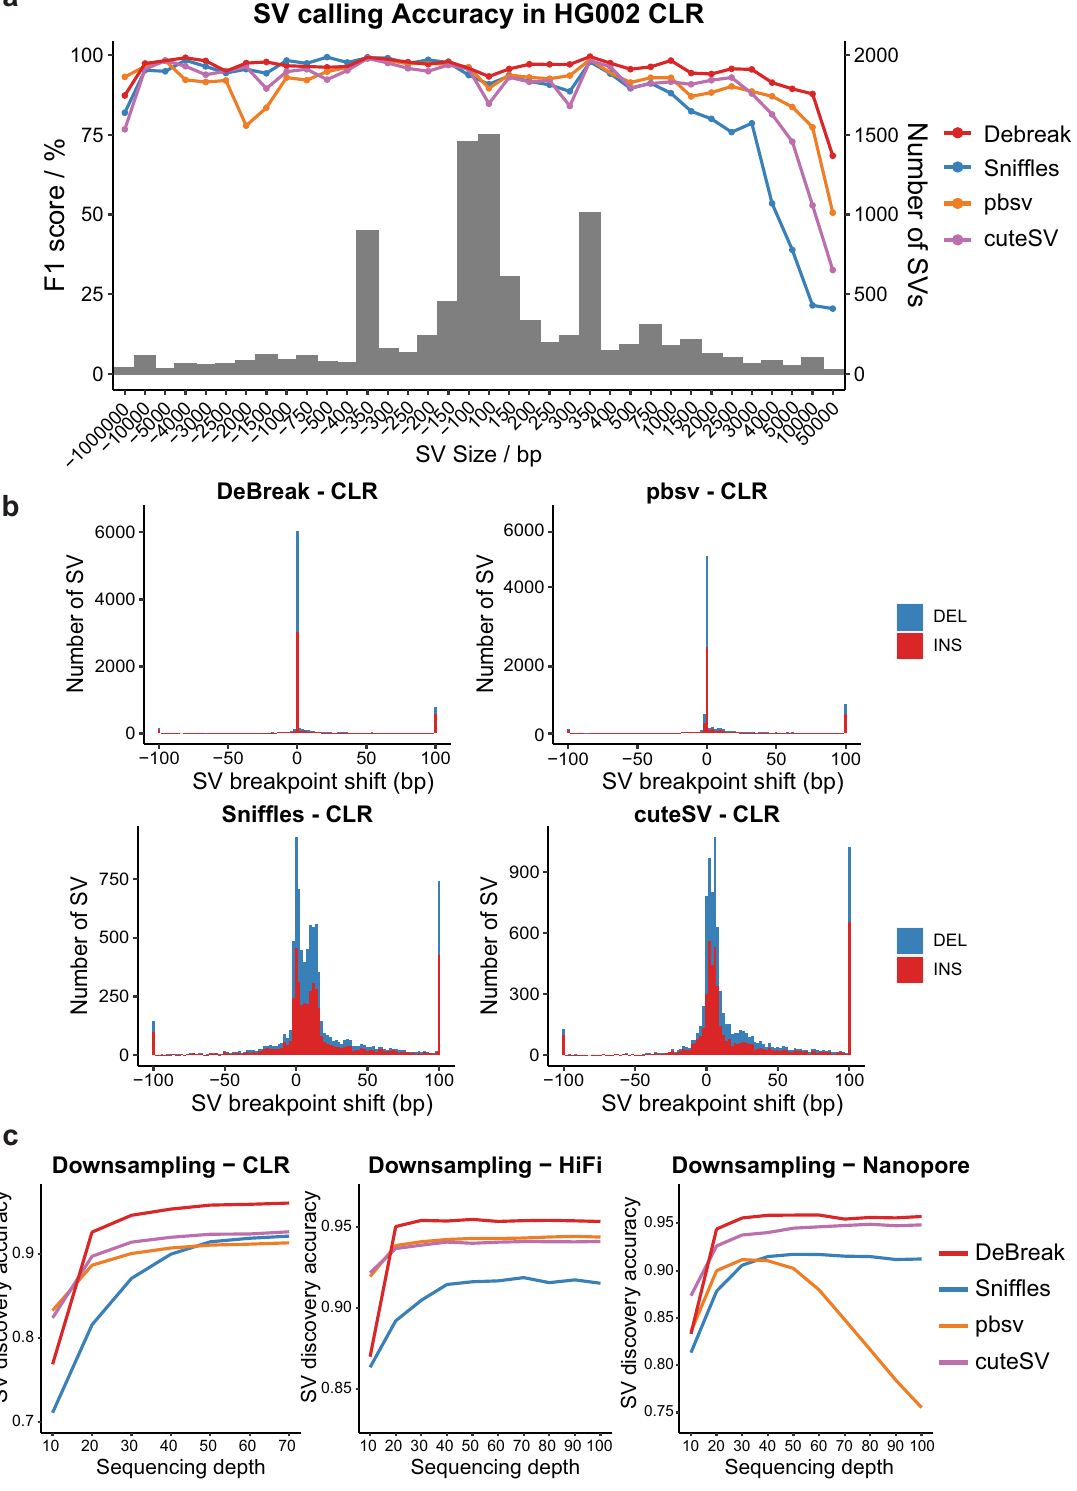
Fig.2|SVdiscoveryinHG002.a SVdiscoveryaccuracyforinsertions(positiveSV size) and deletions (negative SV size) at different size ranges in the CLR dataset. BarsindicatethenumberofSVsineachsizerange,andlinesshowtheSVdiscovery accuracy for each SV caller. b SV breakpoint accuracy for four tested SV callers in